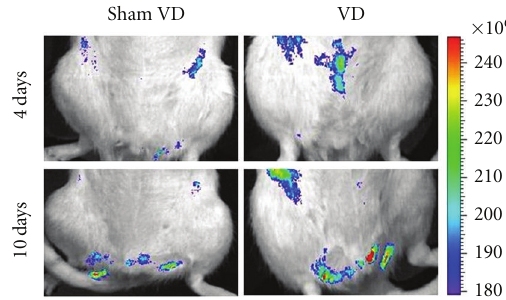
Figure 1: Examples of in vivo fluorescence images for GFP+ mesenchymal stem cells 4 and 10 days after vaginal distension (VD) and sham VD. The colored scale represents total fluorescent flux (photons/second/cm 2 /steradian).